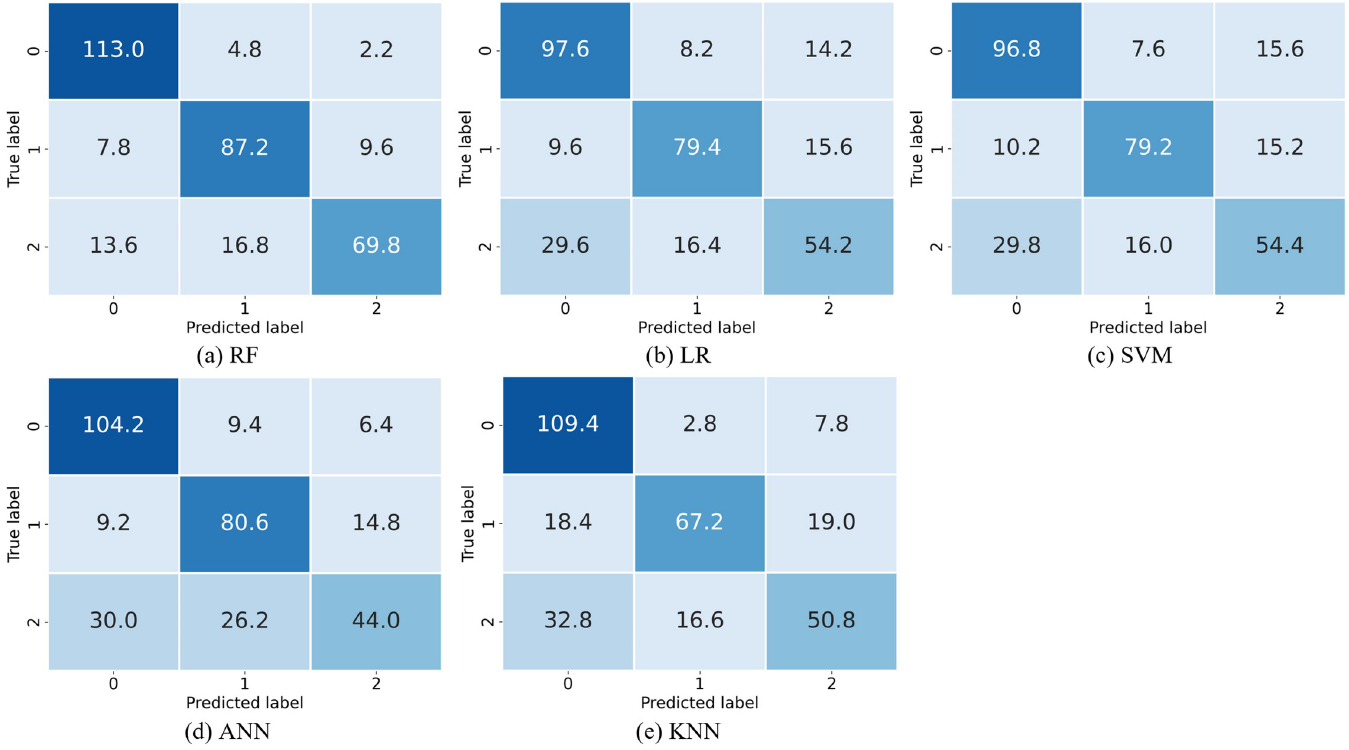
Fig 2. The confusion